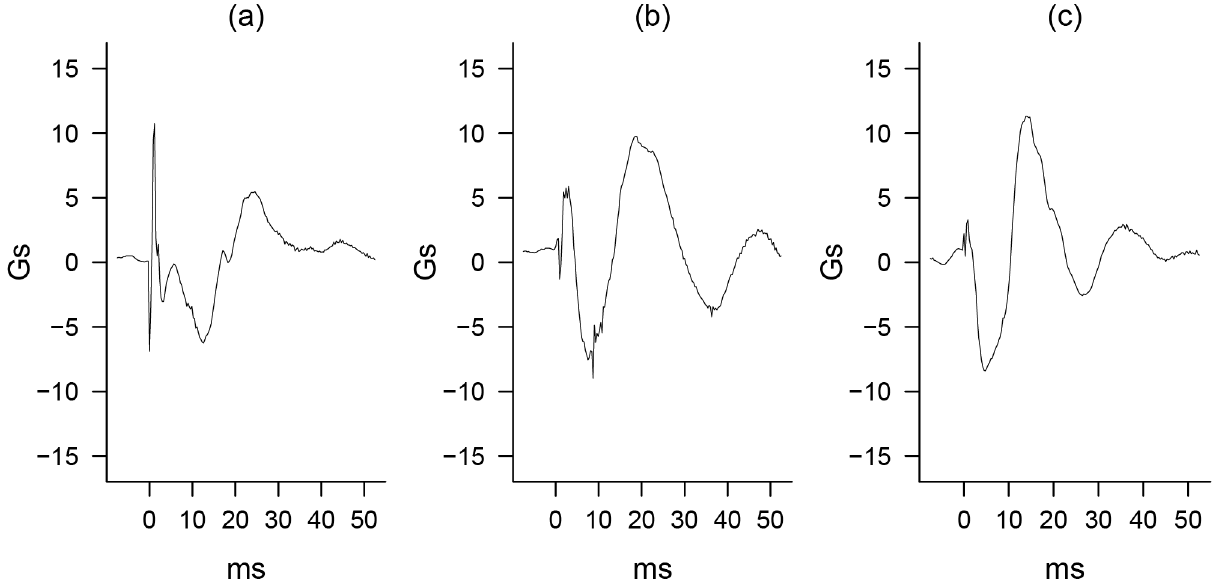
Figure 1. Wrist-Measured Gunshot Example (.38 caliber). Acceleration along the (a) X-axis, (b) Y-axis, and (c) Z-axis.